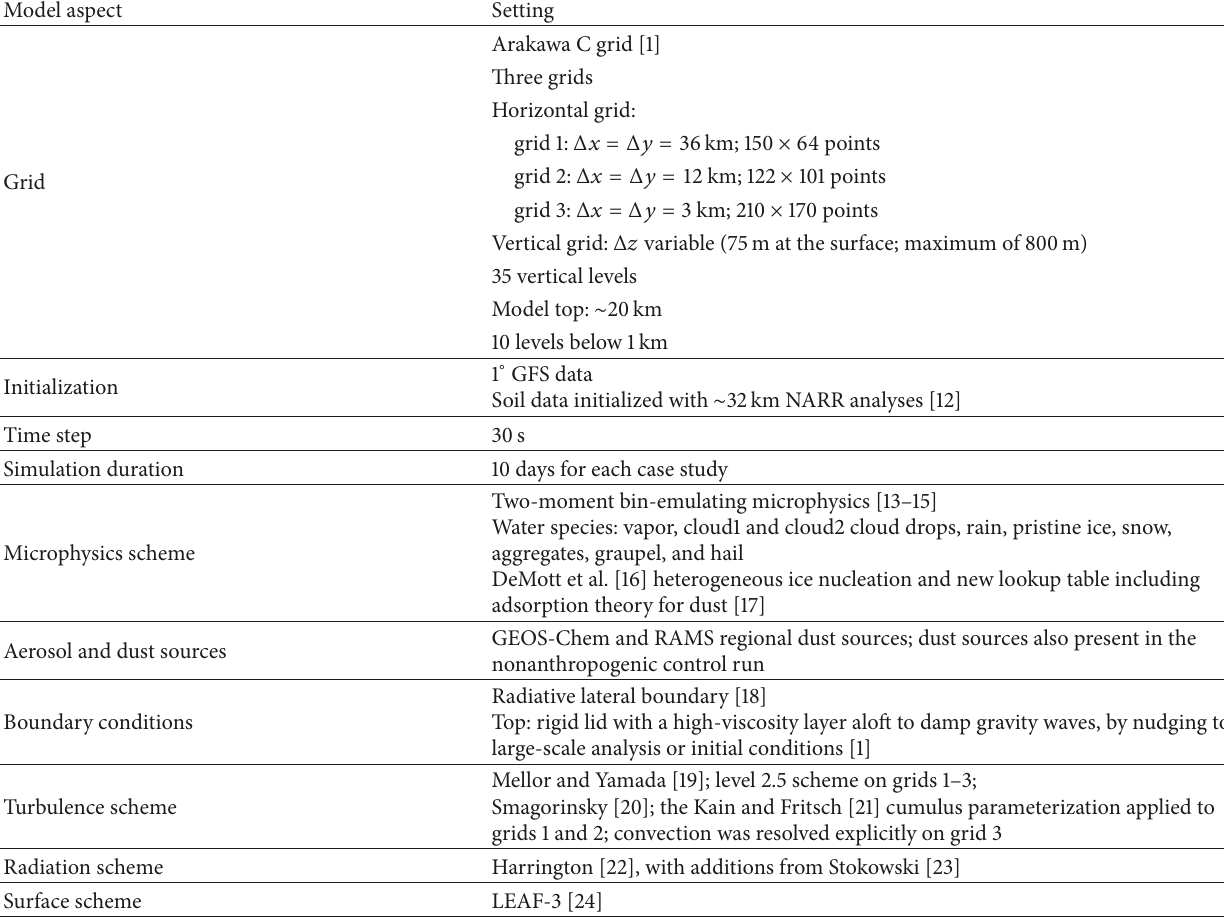
Table 1: RAMS model